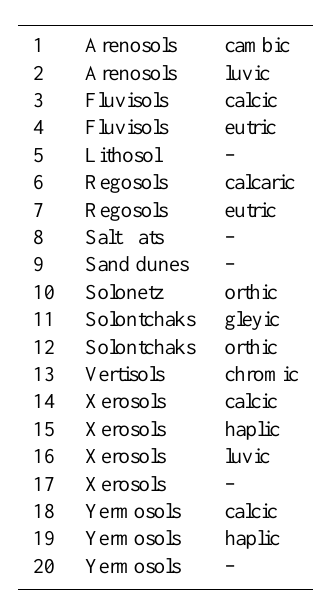
Table 3. Soil units used for comparison of databases (see Fig.